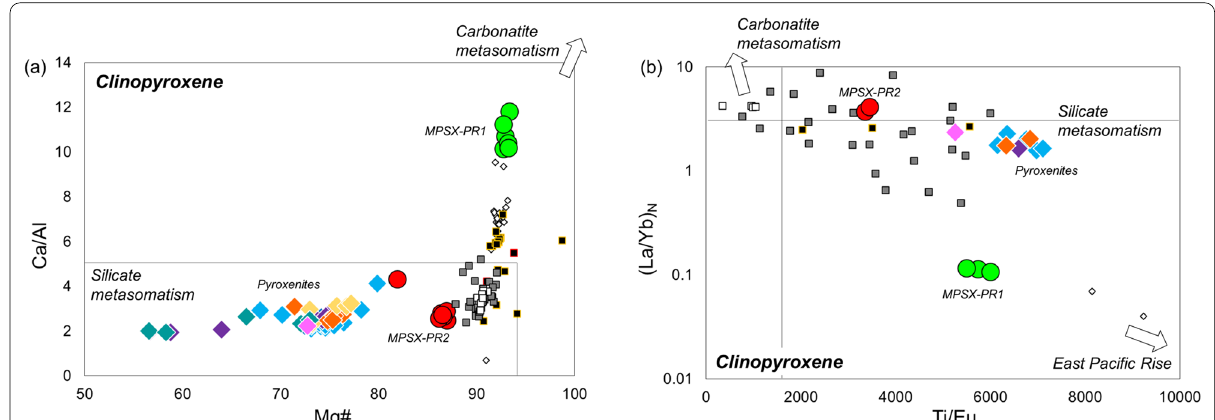
Fig. 9 a Diagram of Mg# versus Ca/Al. b Diagram of Ti/Eu versus (La/Yb) N . (La/Yb) N is the chondrite normalized value. The data for the chondrites are from Sun and McDonough (1989). The ranges of silicate metasomatism and carbonatite metasomatism are from Coltorti et al (1999) and Zong and Liu (2018). Symbols are as for Fig.